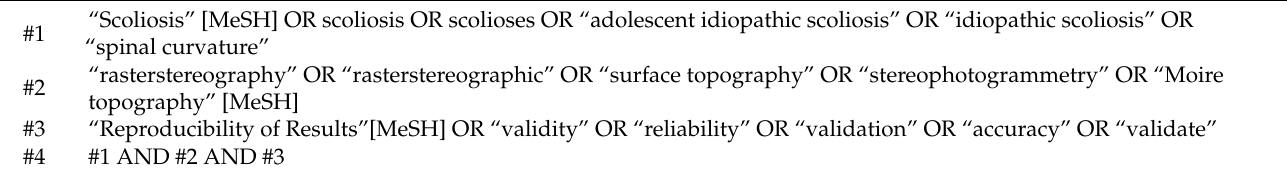
Table 1. Search strategy of